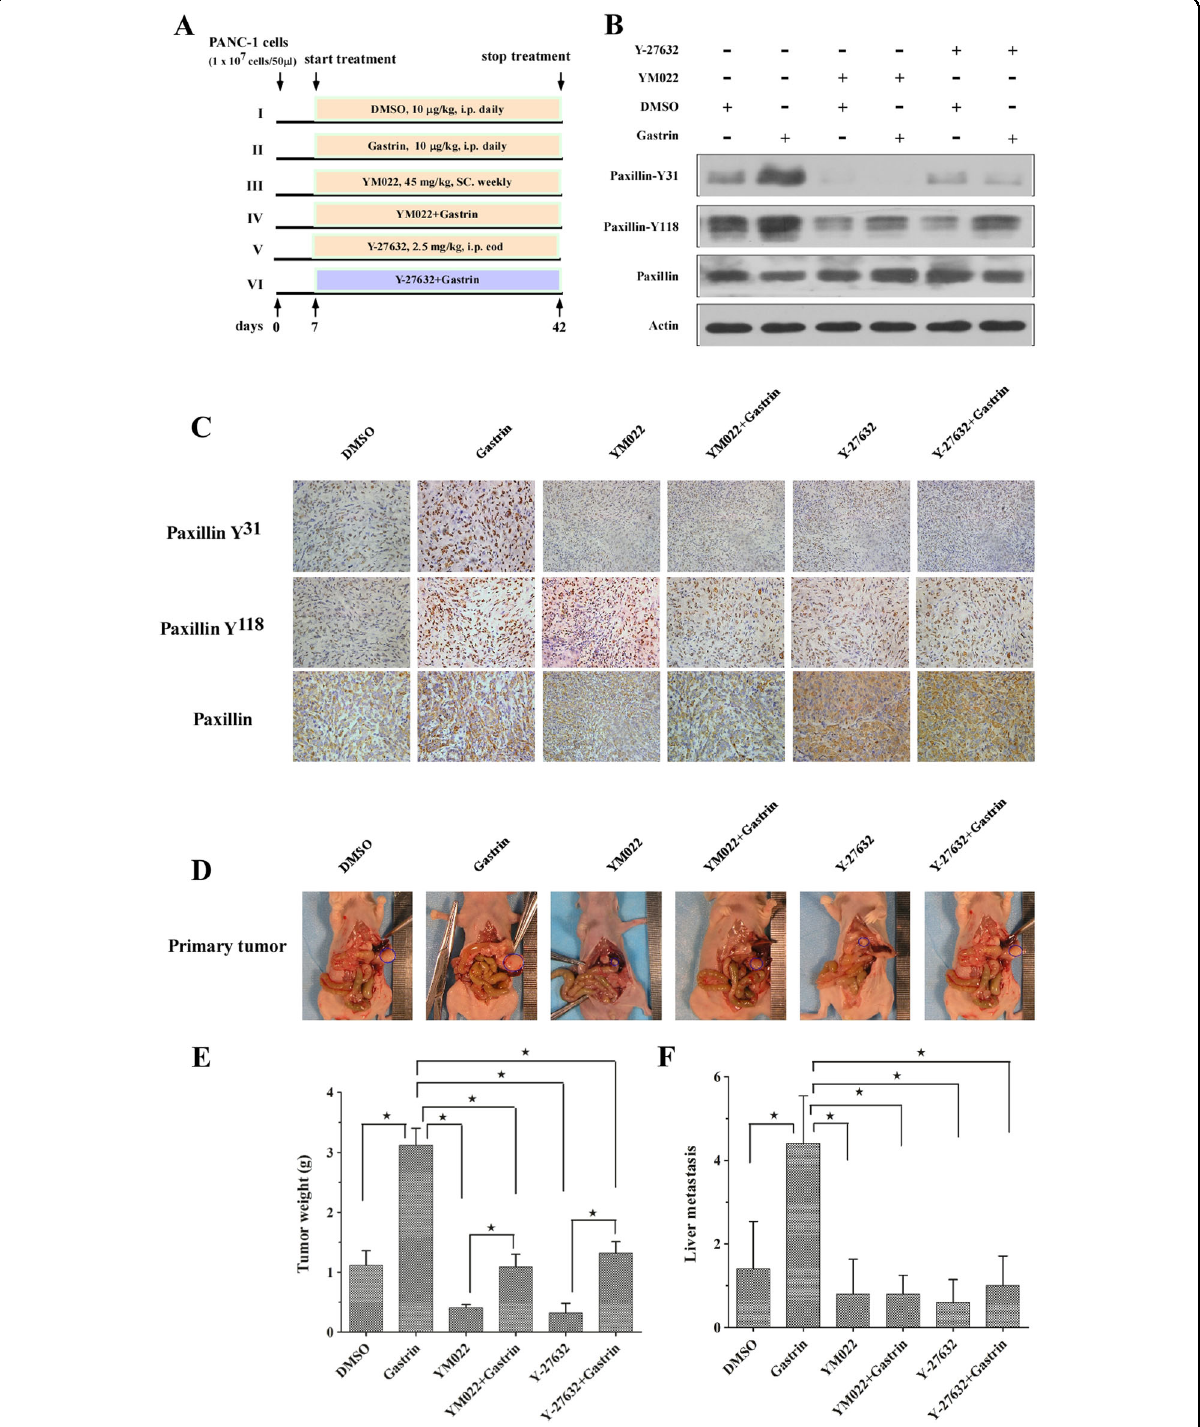
Fig. 6 Gastrin promotes tumor progression of orthotopic tumors in nude mice. PANC-1 cells (1 × 107 cells) were injected into the head/neck region of the nude mouse pancreas. a Mice were divided into six groups and treated according to schedule. b , c Immunoblotting ( b ) and immunohistochemistry ( c ) results are indicated for paxillin phosphorylation of orthotopic pancreatic cancer tissues. d – f YM022 and Y-27632 signi fi cantly inhibited the growth of the primary pancreatic tumor ( d , e ) and prevented liver metastasis ( f ). Data are represented as the mean ± SD, * P <